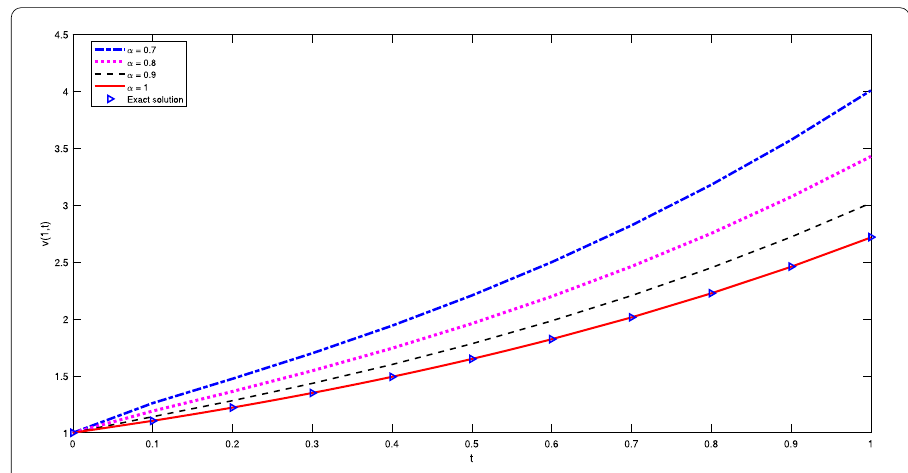
Figure 1 Evolution of LTVIM’s fourth iteration approximate solution of Example 4.1 for x = 1, t ∈ [0,1] and different values of